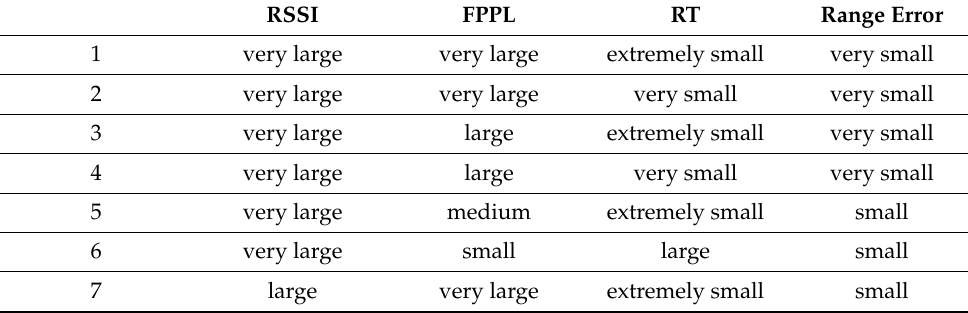
Table 1. The fuzzy rules based on RSSI, FPPL and RT of